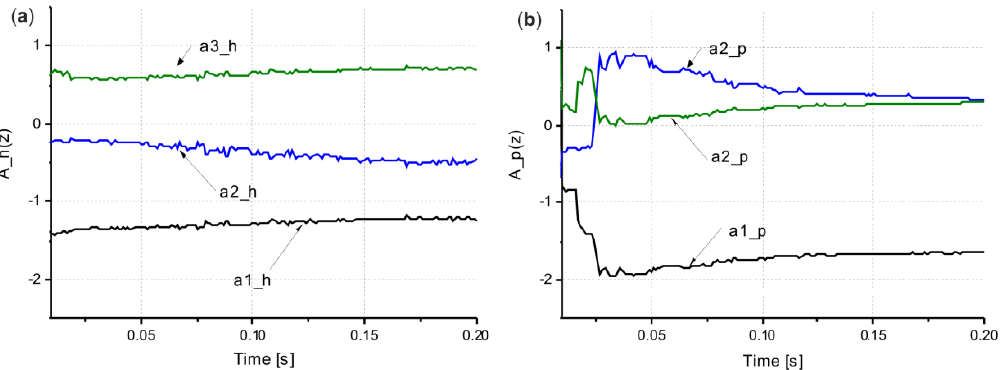
Figure 14. Identified polynomial parameters of the predictive model: ( a ) height of deformed forgings ( b ) load pressure in the working cylinder.